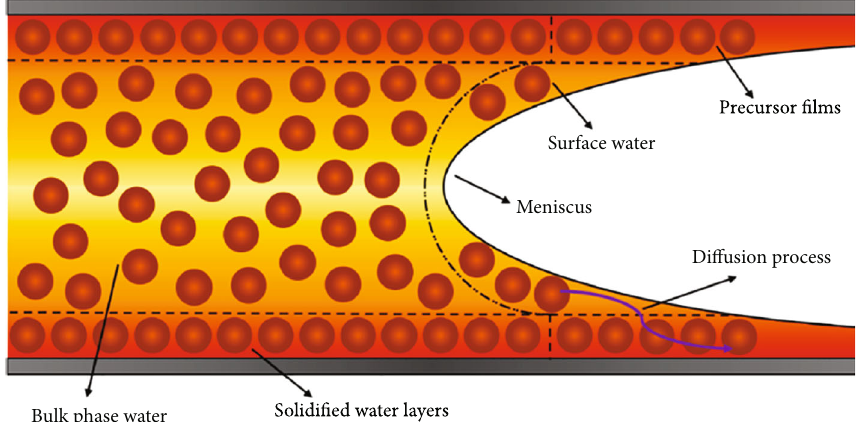
Figure 8: A spontaneous imbibition process with precursor fi lms for water in a nanopore